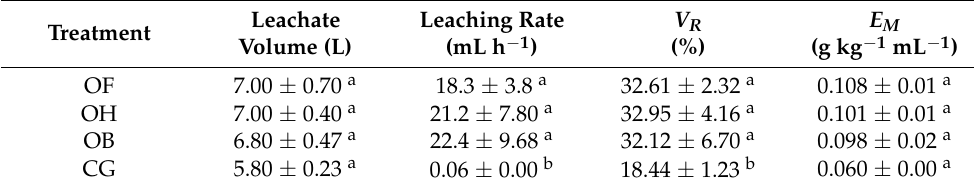
Figure 3. Variation of salt content between different treatments before and after leaching. Different lowercase letters represent significant differences between treatments under the same cumulative water volume in the 0–20 cm layer, and different capital letters represent significant differences between different treatments under the same cumulative water volume in the 20–40 cm layer ( p < 0.05). *** means a significant difference between initial salt content and final salt content under the same treatment ( p < 0.01); ns means no significant difference. Table 5. Desalination efficiency in different columns.